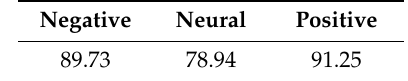
Table 4. F1 percentages of each class